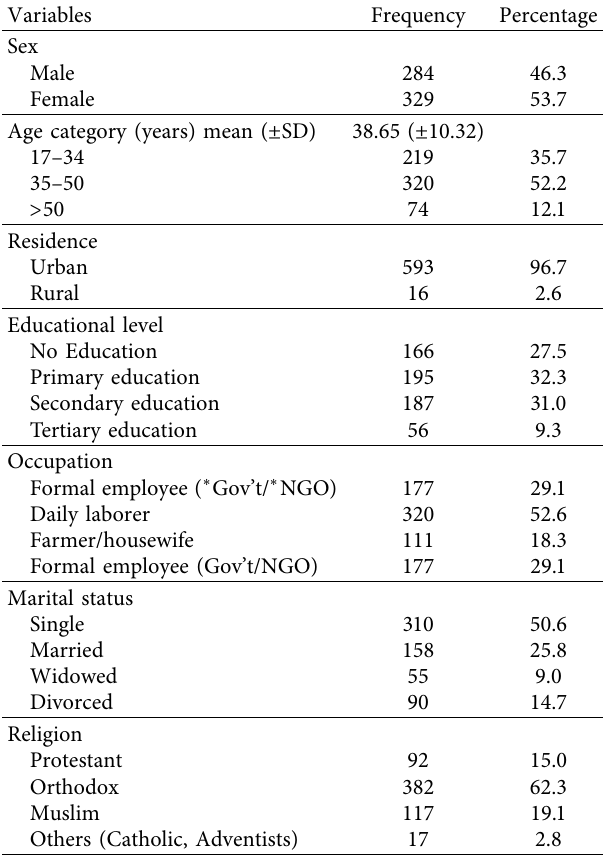
Table 1: Sociodemographic characteristics of patients under ART in health centers at Kirkos subcity Addis Ababa, Ethiopia,